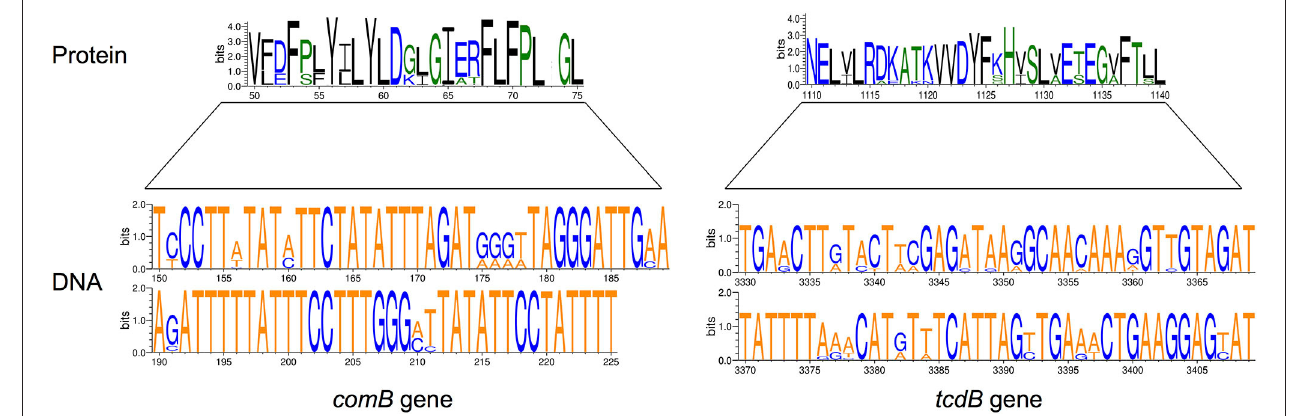
FIGURE 2 | Examples of variation in virulence genes and proteins affecting VAD targets. The size of letters representing nucleotides (DNA) or amino acids (Protein) reflects their relative frequency in individual positions in the VAD target gene. Only 6% of Streptococcus pneumoniae comB gene (75-bp of 1,326-bp gene) and 2% of Clostridium difficile tcdB gene (90-bp of 7,101-bp gene) are shown; multiple sequence variations with amino acid relevance are present. Amino acids are colored according to their chemical properties: polar amino acids are green, basic blue, and hydrophobic are black. The height of the y-axis indicates the maximum entropy for the given sequence type. Prepared using Weblogo